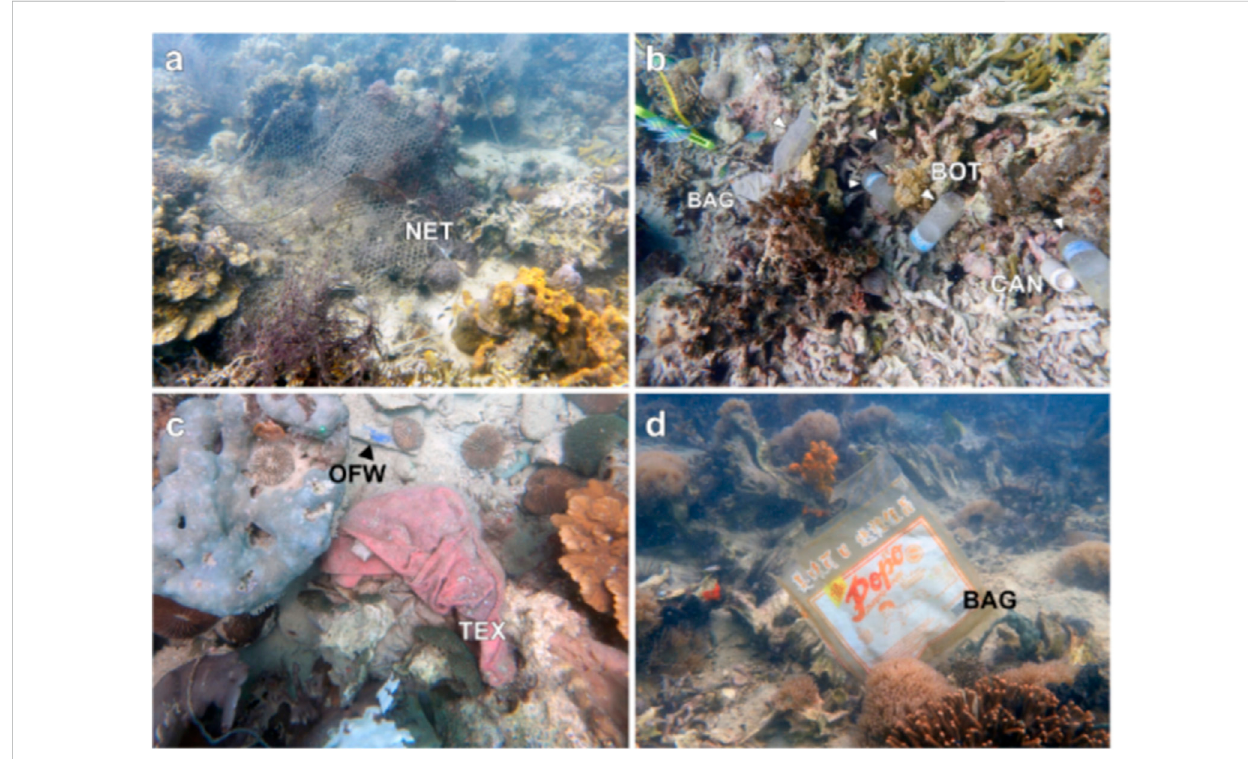
FIGURE 4 Examples of marine litter found in the Darvel Bay reefs: (A) Abandoned fi shing net in the Triangle Reef at 10 m depth, (B) plastic bag (BAG), plastic bottles(BOT),andaluminumcan(CAN)inBaikat5 mdepth, (C) otherfoodwrap(OFW)andtextiles(TEX)inSakarat5 mdepth,and (D) plasticbag(BAG)in Sakar at 10 m depth (Santodomingo et al.,